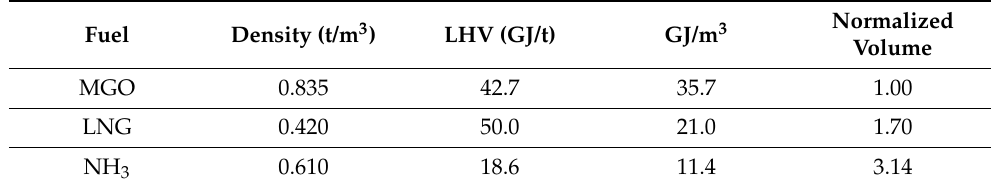
Table 1. Physical characteristics of different marine fuels with